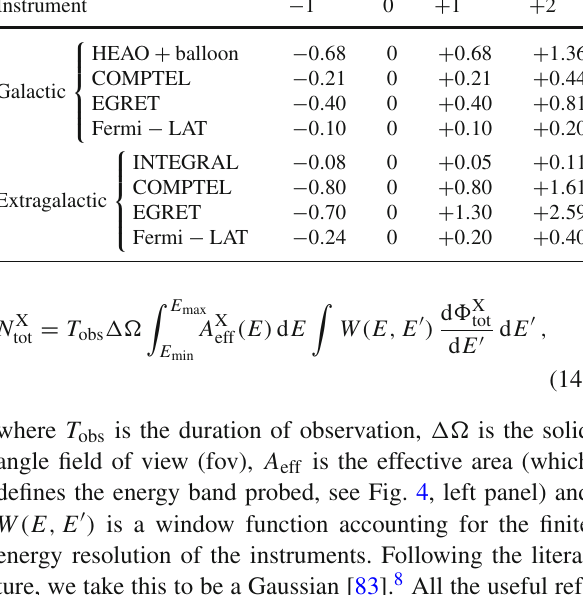
Table2 Relativeextremalvariationin f PBH whenusingthesameback- ground as [19] or the central values of the data points compared to the background of [70] for the instruments of Fig.